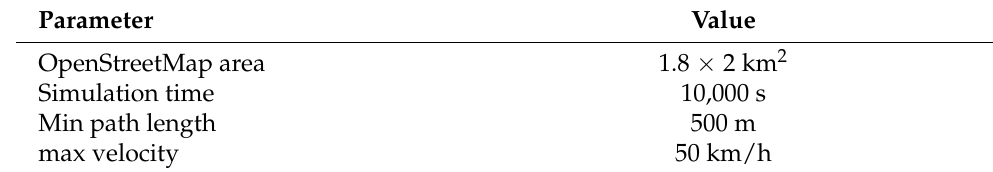
Table 1. SUMO simulation